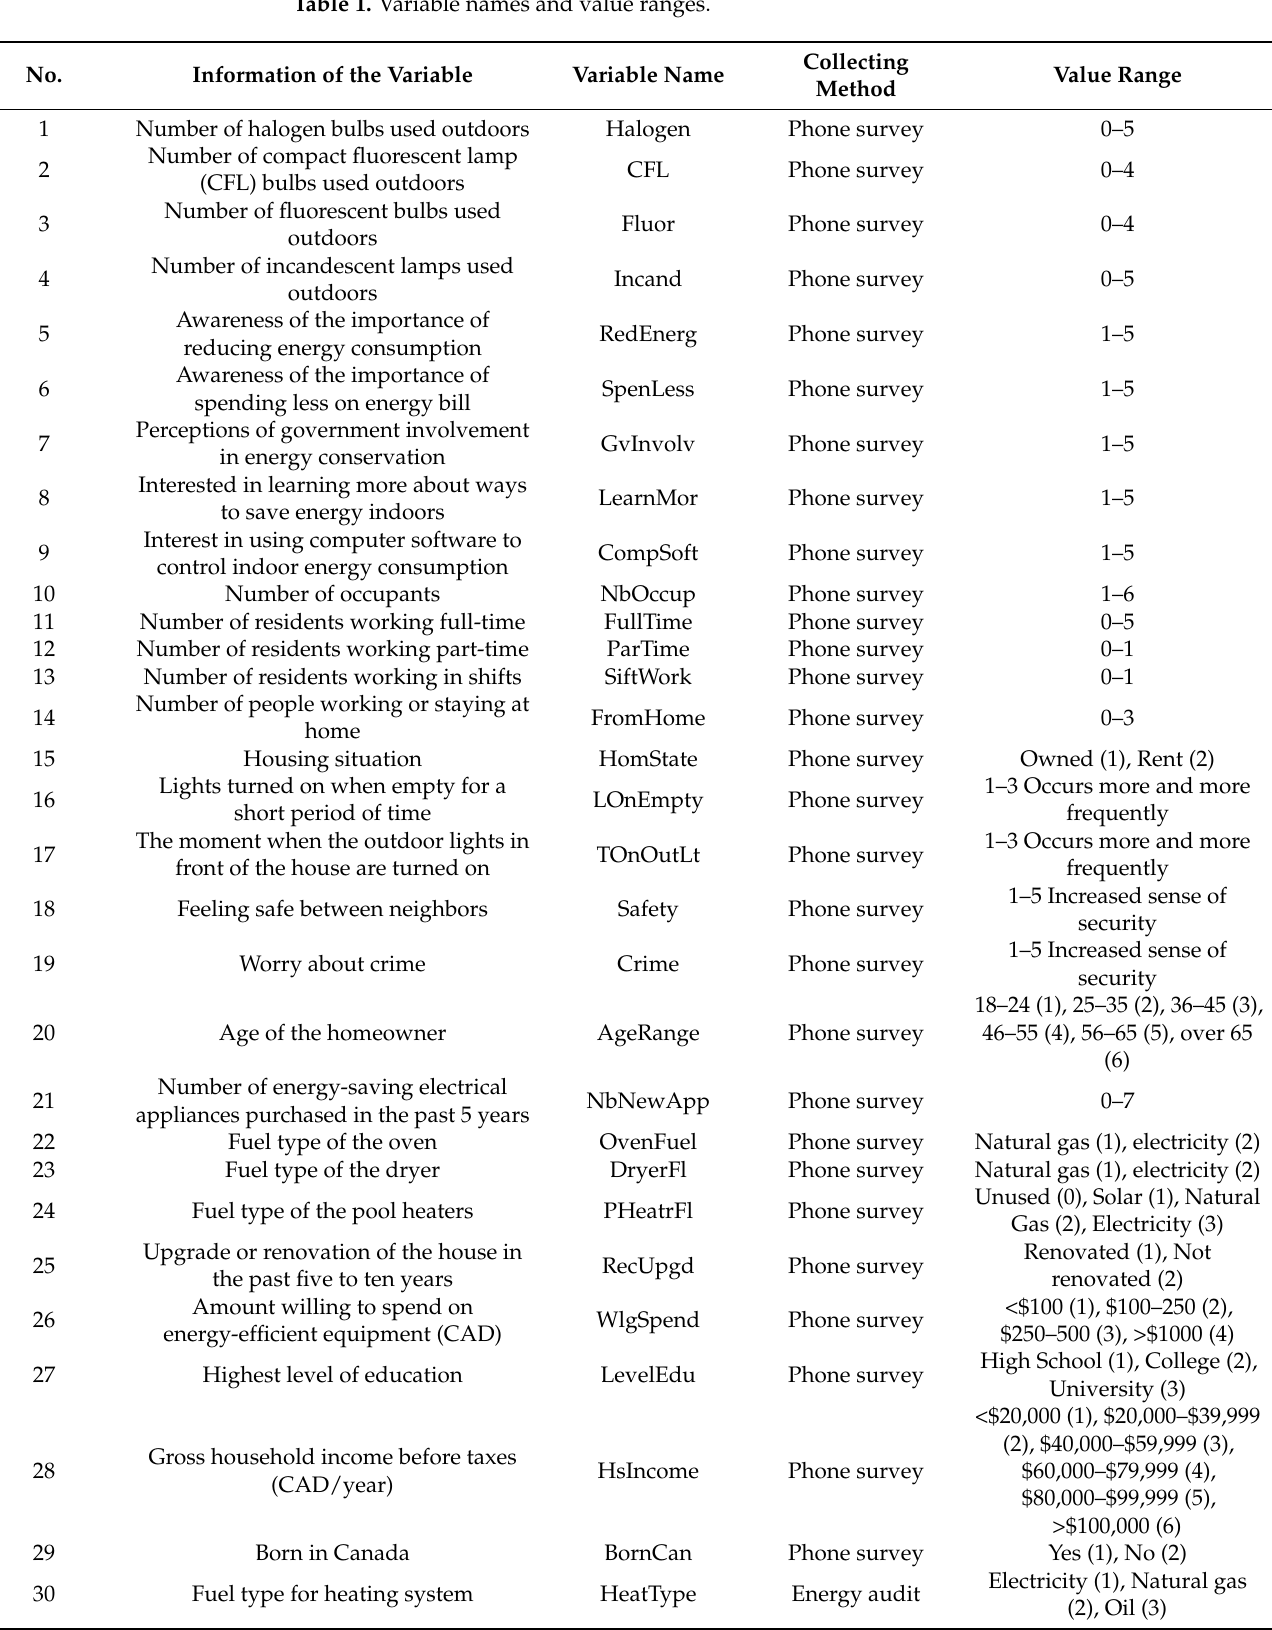
Table 1. Variable names and value